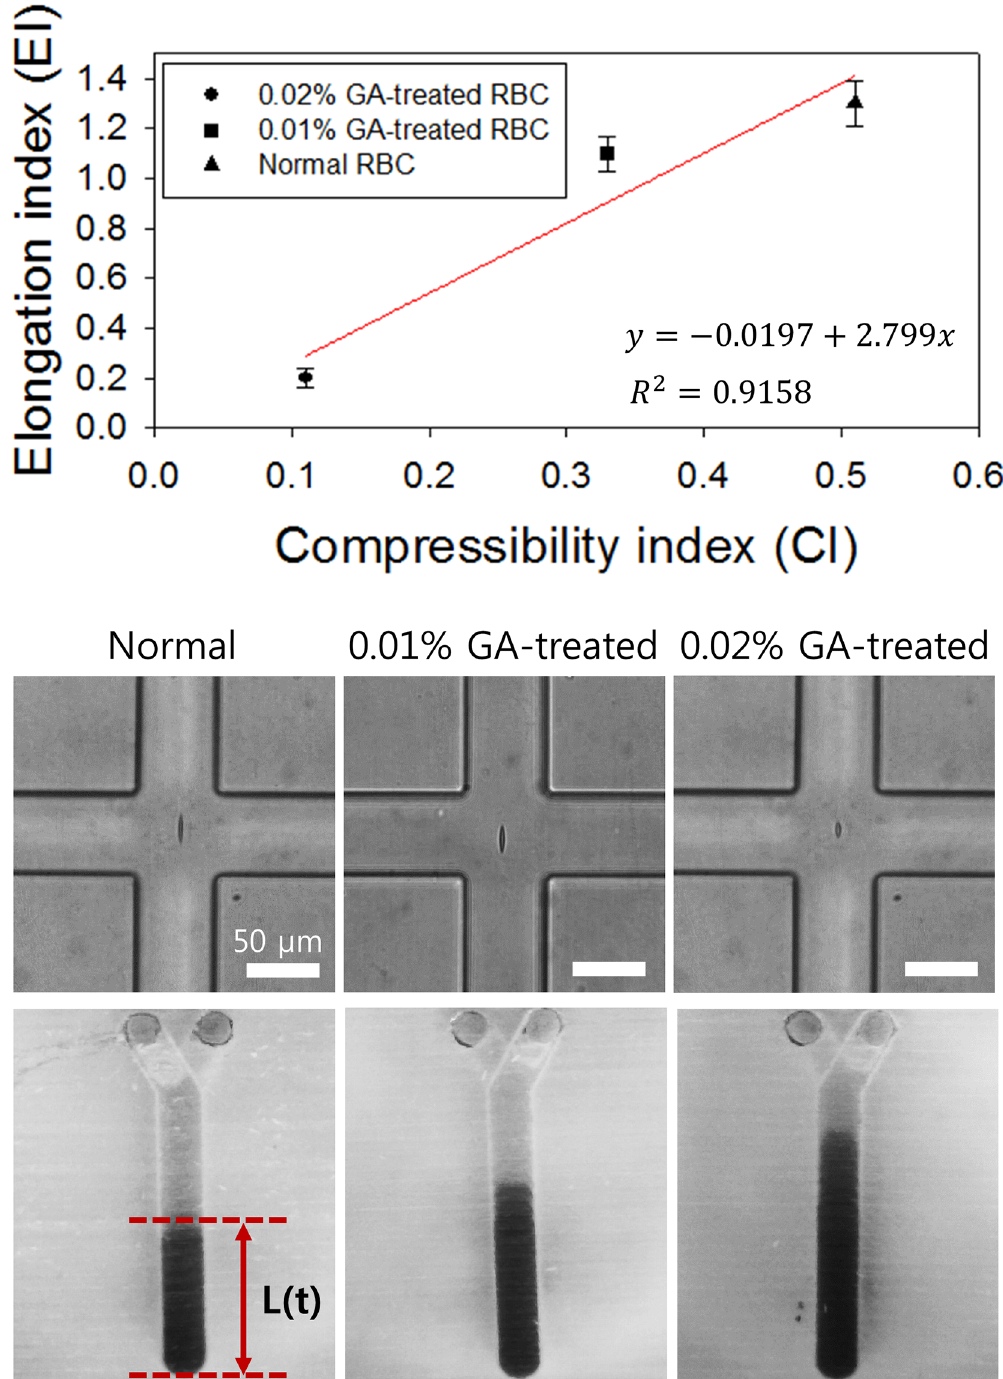
Fig 4. Validation of CIs measured using a 3D-PMD device. Relation between compressibility indices (CIs) measured using a 3D-PMD device and elongation indices (EIs) measured using a viscoelastic cell deformability measurement technique depending on RBC rigidity. The standard deviation shows the measured values from ten different measurements (n = 10). Photographs of stretched RBCs in a cross-shaped channel and single units of the fluidic channel of the 3D-PMD device.